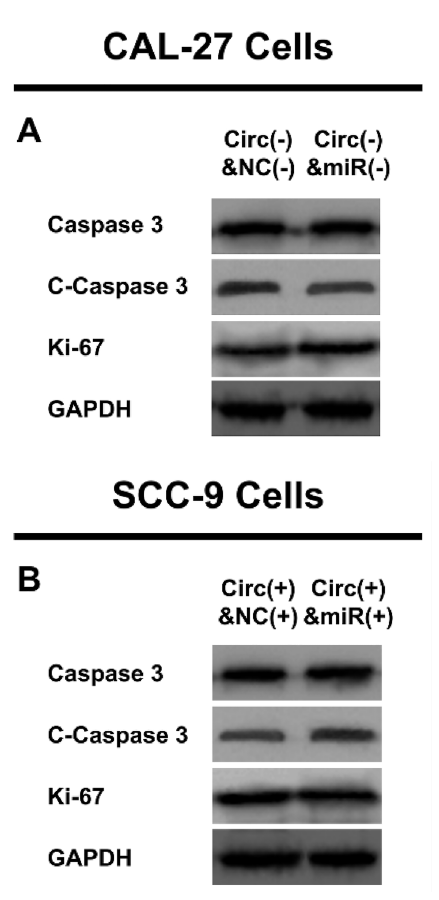
Figure 8. A, Effect of miR-33a-5p on proliferation/apoptosis protein expressions in hsa_circ_0002162 dysregulated CAL-27 cells. B , Effect of miR-33a-5p on proliferation/apoptosis pro- tein expressions in hsa_circ_0002162 dysregulated SCC-9 cells. NC: negative control; GAPDH: glyceraldehyde-phosphate dehydrogenase.